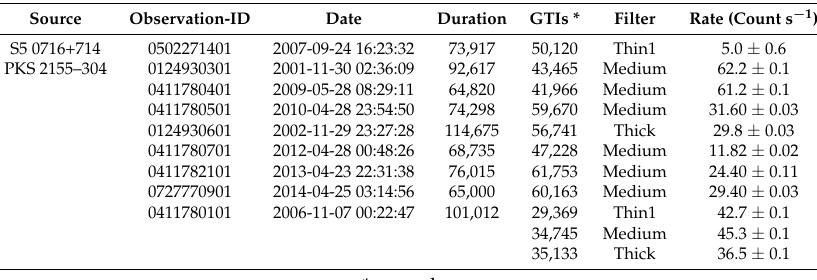
Table 1. Details of XMM-Newton observations considered in this